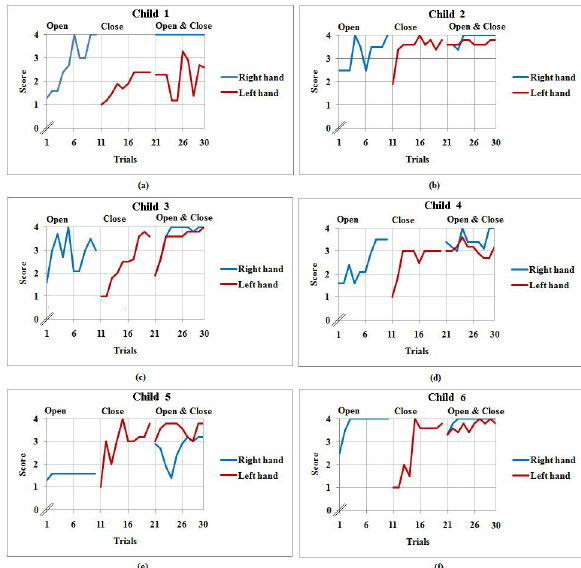
Figure 4: Learning curves of the children for the first thirty trials.